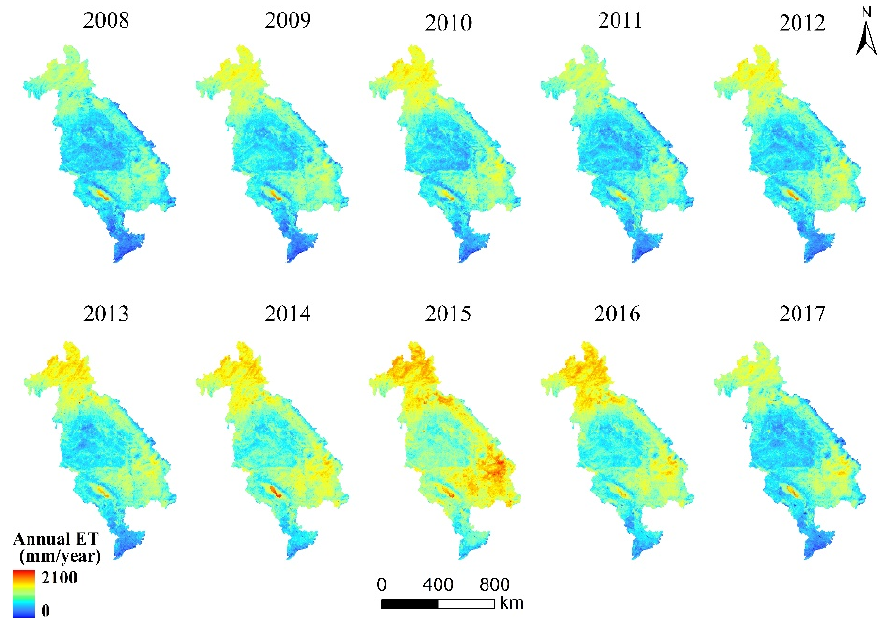
Figure 6. The spatial distribution of average annual ET from 2008 to 2017 in the Lower Mekong River basin.